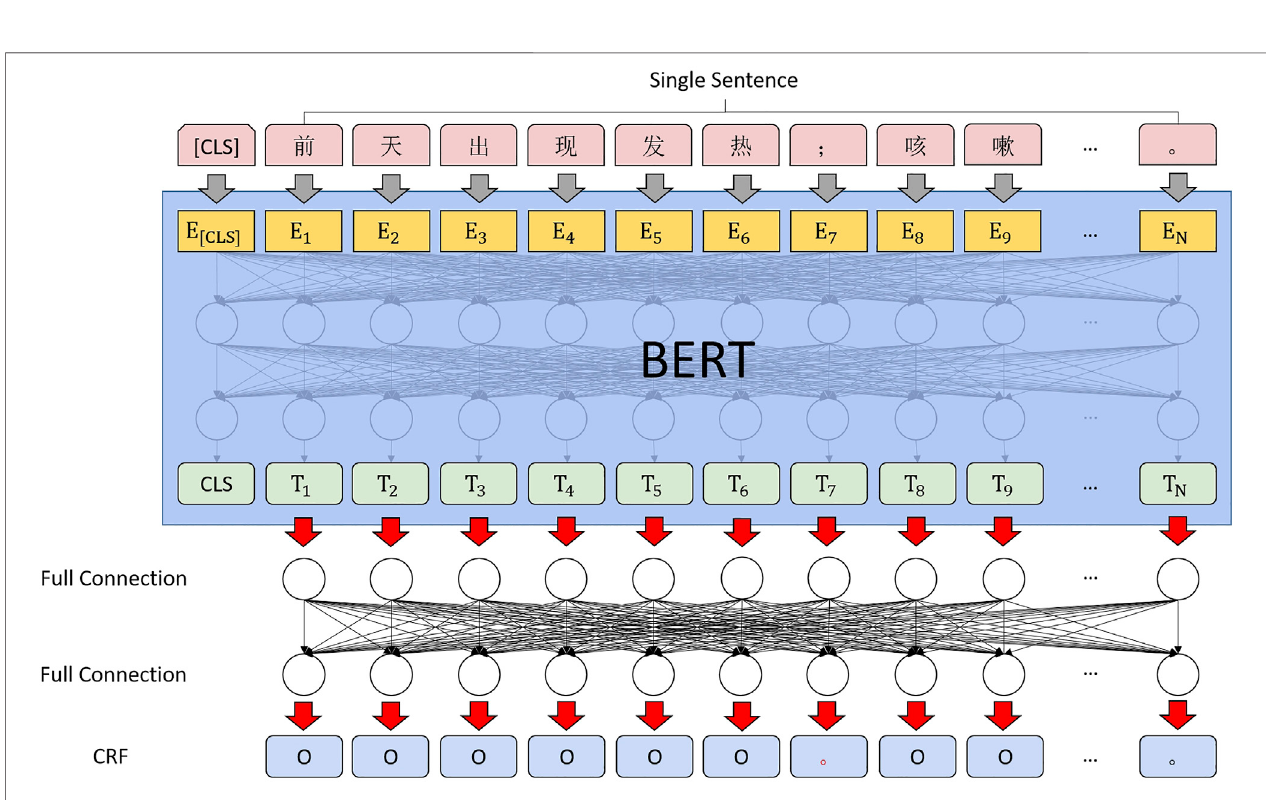
FIGURE 4 | Correct misuse of punctuation in clinical record text.